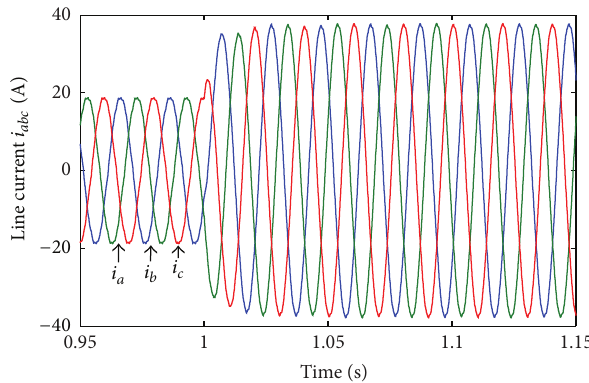
Figure 14: Optimal switching angles response to load disturbance.